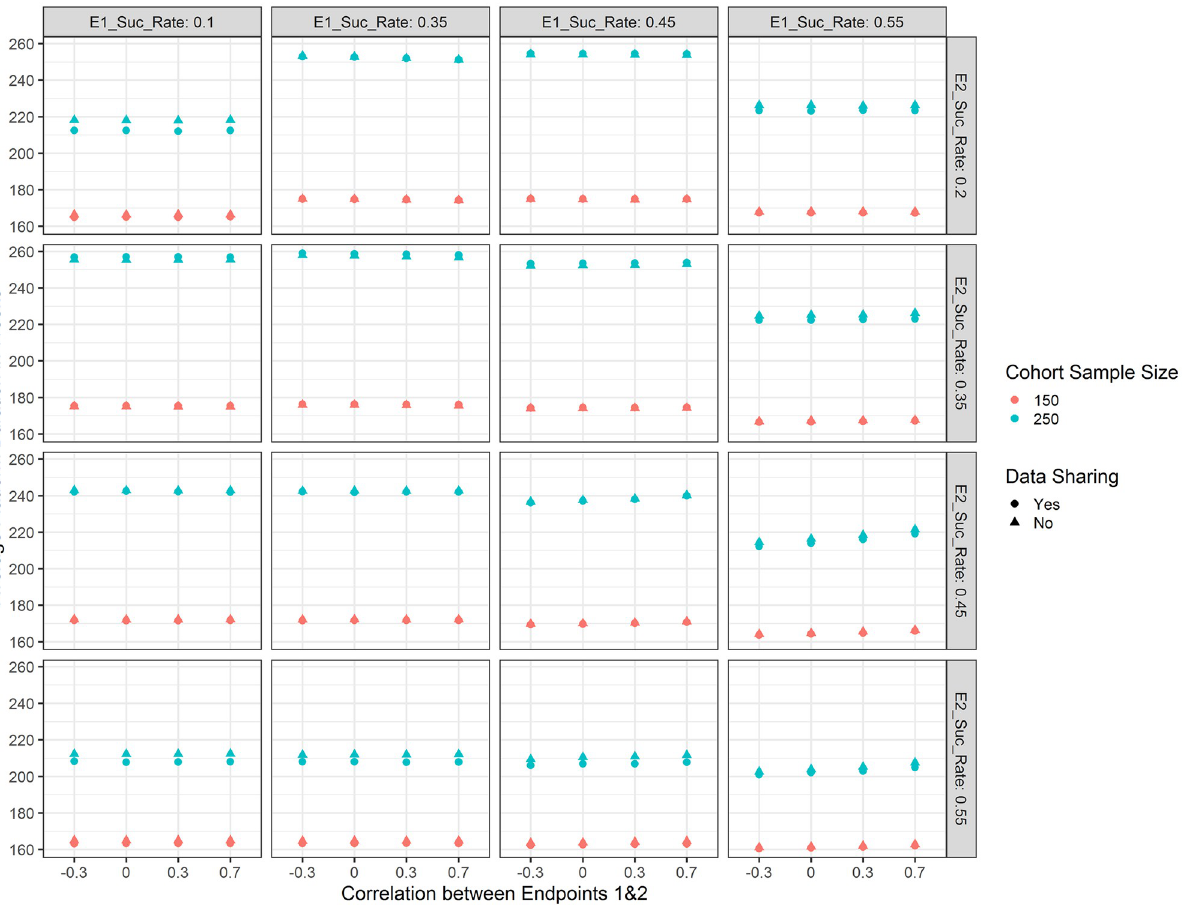
Fig 5. Average platform trial duration in weeks with respect to the response rate for endpoint 1 (E1_Suc_Rate; columns), the response rate for endpoint 2 (E2_Suc_Rate; rows), the correlation between the two endpoints (x-axis), the type of data sharing used (point shape) and the planned cohort sample size per arm